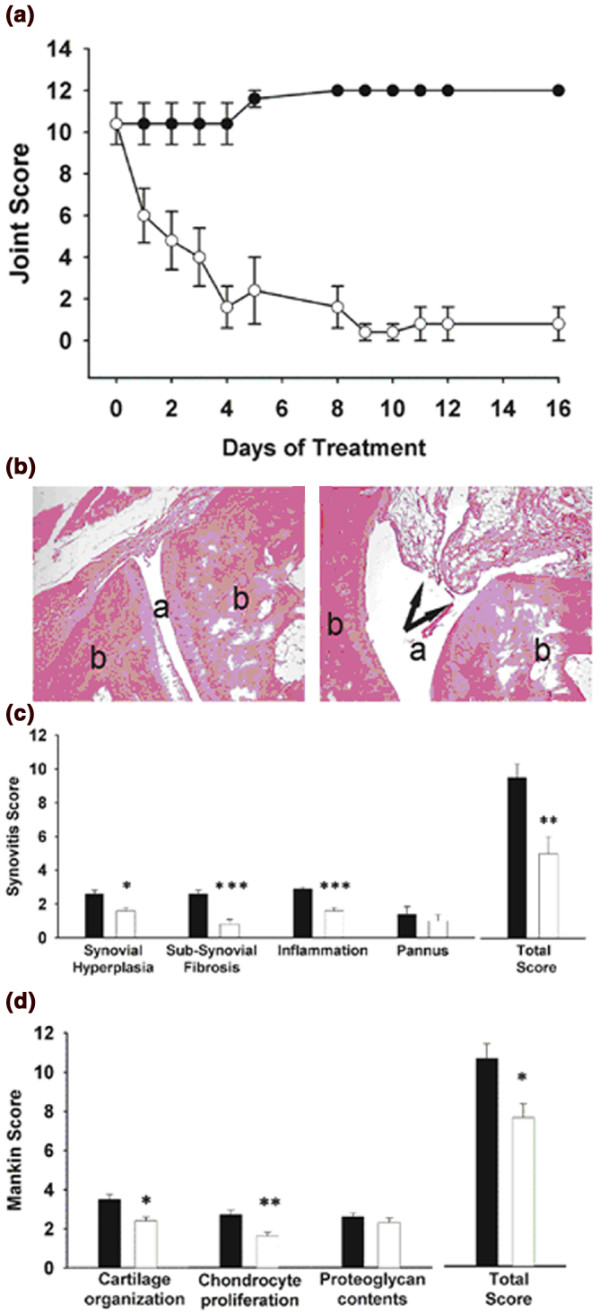
Effect of mAb C11C1 on HLA-B27 transgenic rat inflammatory arthritis. (a) Effects of monoclonal antibody (mAb) C11C1 on clinical signs of arthritis in human leukocyte antigen B27 (HLA-B27) rats. mAb C11C1 was administered at the same dose and frequency as in Fig. 2a. Mean joint score was determined daily, except at weekends. All joint scores are significantly different between the two groups for each corresponding day (P < 0.001) except for days 1 (P > 0.03), 2 (P = 0.01) and 3 (P = 0.006). Data are shown as means ± SEM. Filled circles, IgG1-treated group; open circles, mAb C11C1-treated group. (b) Effects of mAb C11C1 on joint histology in HLA-B27 rats. Photomicrographs of representative sections of tarsal joints from C11C1-treated (left) and IgG-treated (right) HLA-B27 transgenic rats. Note the clear joint space (a) and normal appearance of bone (b) in the mAb C11C1-treated group (left) compared with the inflamed villus formation (arrows) occupying the synovial space (a) in the IgG-treated group (right). Hematoxylin and eosin stain; original magnification × 100. (c) Effects of mAb C11C1 on synovial inflammatory changes in HLA-B27 rats. Treatment with mAb C11C1 (open bars) decreased synovial proliferation (hyperplasia) (P = 0.01), subsynovial fibrosis (fibroplasia) (P = 0.001), and degree of inflammation (P < 0.001), but not pannus formation. The total score of the control IgG1 of 9.6 ± 1.0 was reduced by mAb C11C1 to an inflammatory score of 5.0 ± 1.0 (P = 0.009). Data are shown as means ± SEM. *P < 0.05; **P < 0.01; ***P < 0.005. (d) Effects of mAb C11C1 on cartilage and bone inflammatory changes in HLA-B27 rats. mAb C11C1 (open bars) significantly improved (decreased the Mankin score of) the cartilage organization (P = 0.01) and the altered chondrocyte proliferation (P = 0.008). The proteoglycan cartilage contents (Safranin O/Fast Green staining) were similar in both experimental groups (P > 0.05) and the tidemark integrity was preserved (data not shown). The total Mankin score was significantly decreased in the mAb C11C1-treated group (P = 0.02). Data are shown as means ± SEM. *P < 0.05; **P < 0.01; ***P < 0.005.